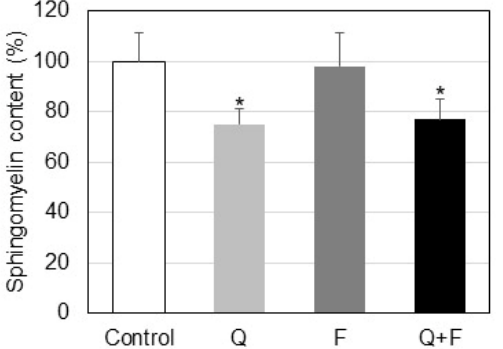
Figure 2. Sphingomyelin content in HepG2 cells untreated (Control) and treated with quercetin (Q) and fingolimod (F). Values are expressed as relative percentage participation in the total lipids. Values are means ± SD. Statistical significance is presented as comparison of treated cells with controls. * p < 0.01.